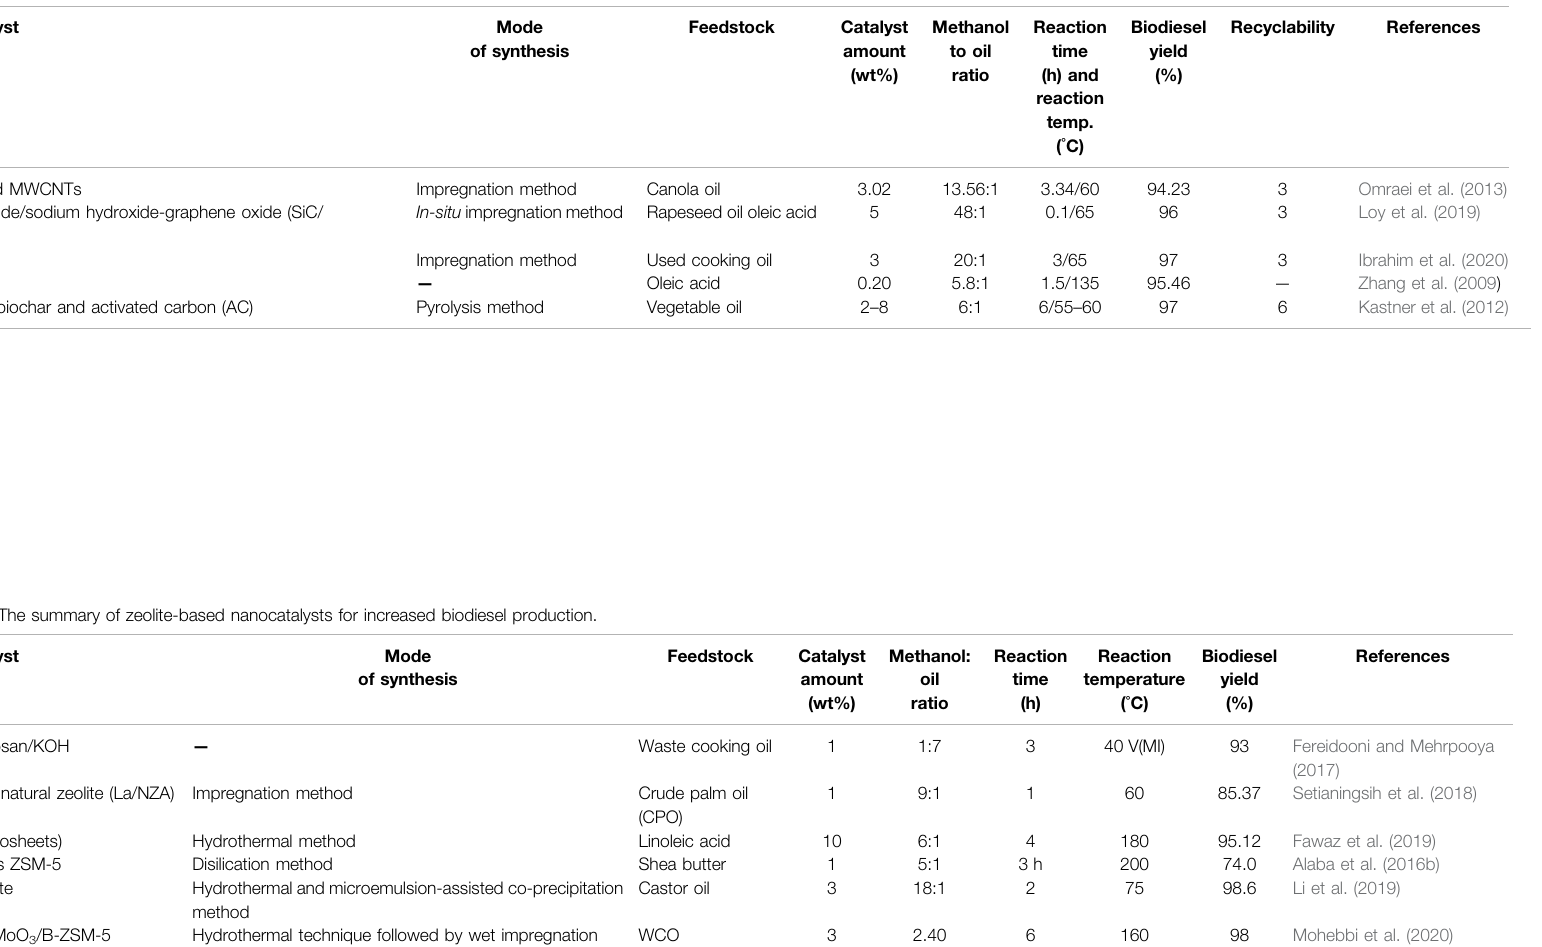
TABLE 5 | Summary of the involvement of carbon-based nanocatalysts in increased biodiesel production.